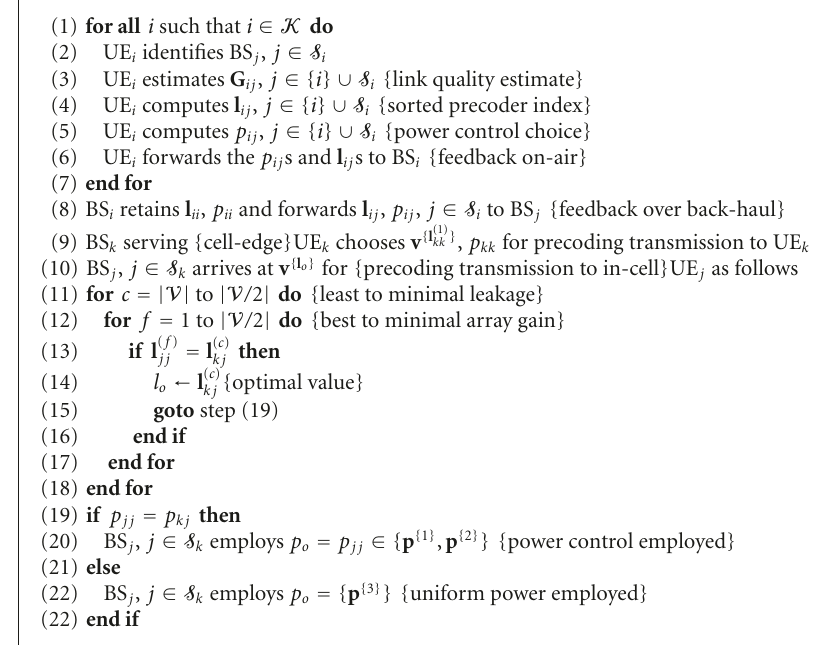
Algorithm 1: The CPS-PC algorithm without multiuser scheduling.